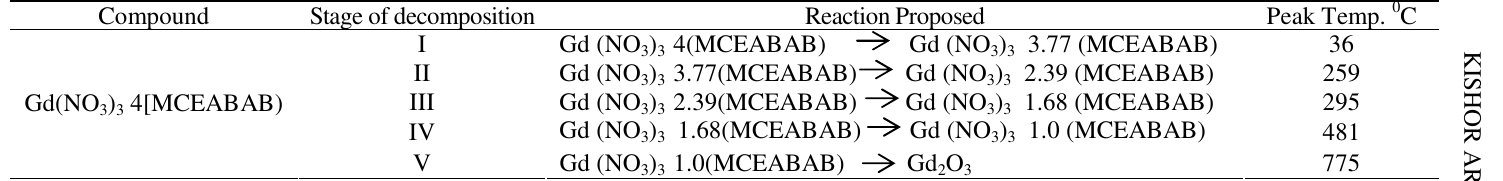
Table 7 . Thermal decomposition data for [Gd(NO